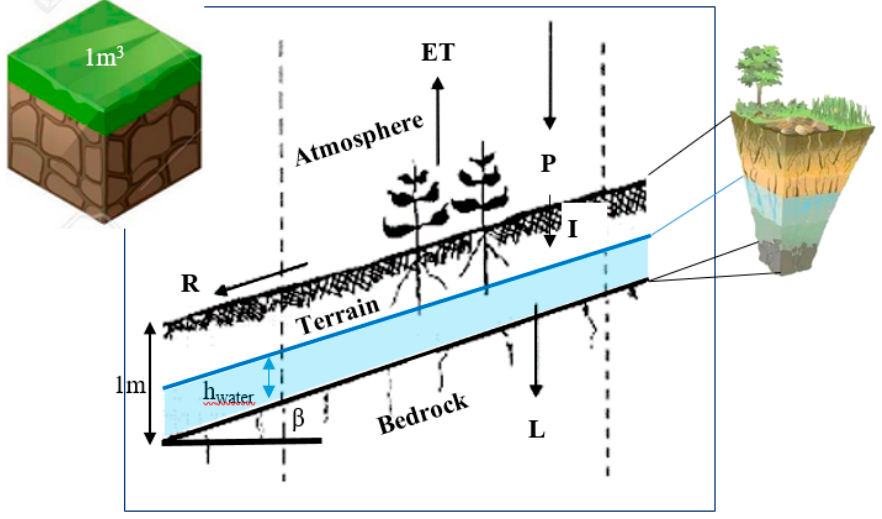
Figure 2. Scheme of the Terrain Water Balance Model and Fluxes. Modified after [9].